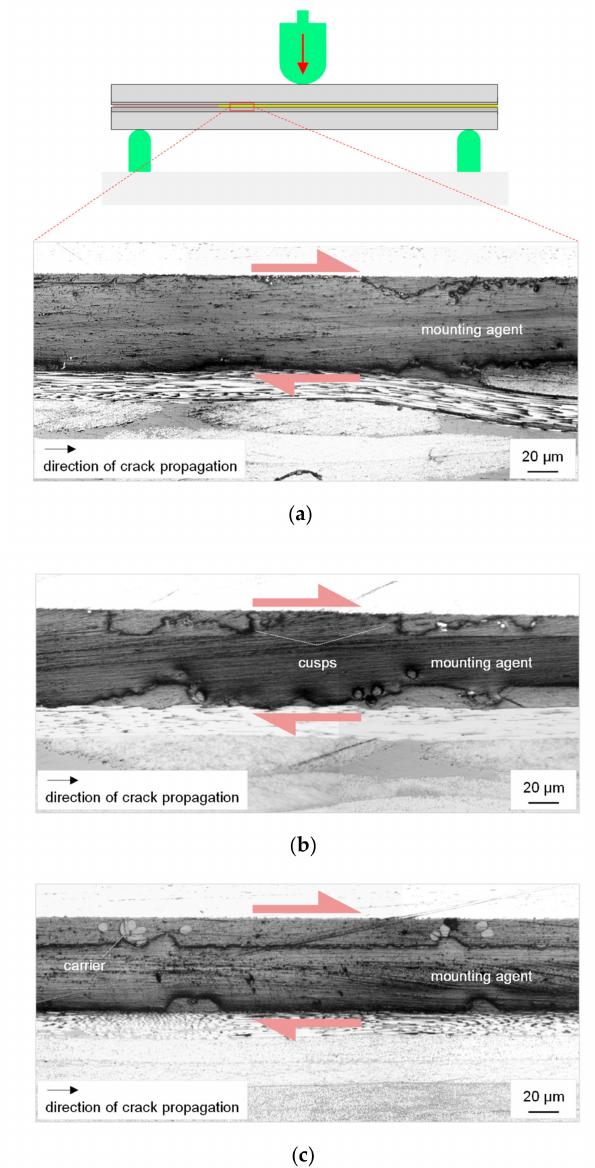
Figure 10. Microscopic images of the side-views of a representative end-notched flexure (ENF) specimen from each of the following manufacturing options (MOs): ( a ) MO 1, ( b ) MO 3, and ( c ) MO